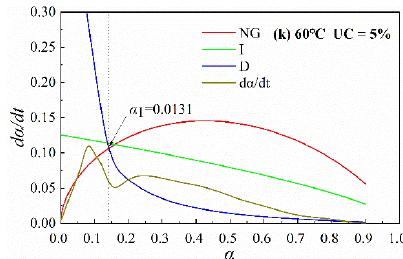
Figure 3. Hydration kinetic model diagram.